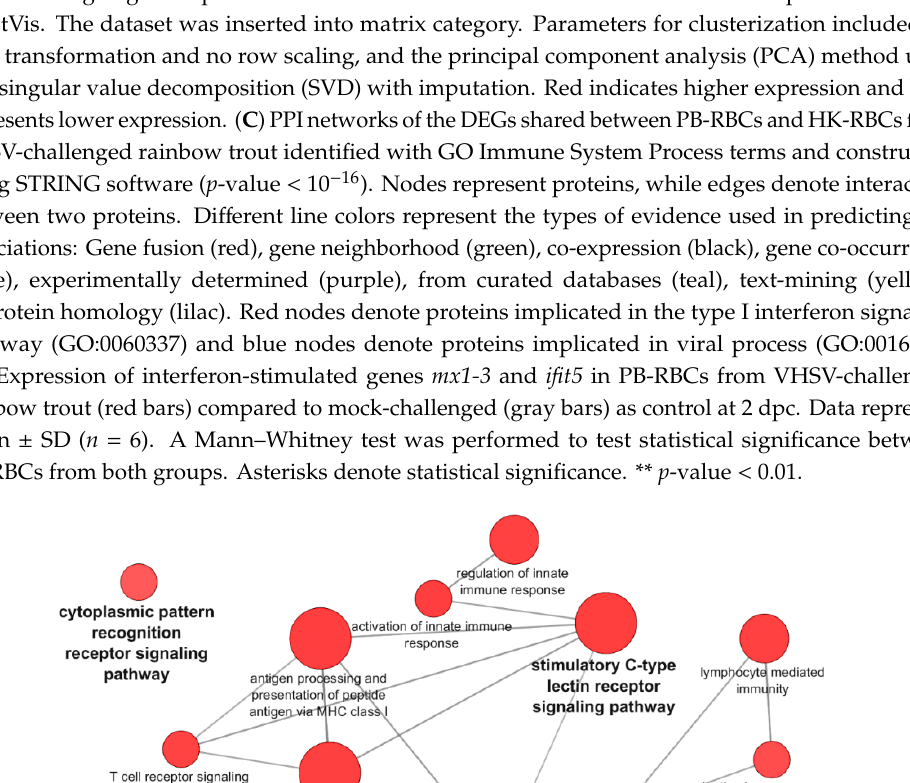
Figure 4. Pathways overrepresented in DEGs exclusive of PB-RBCs from VHSV-challenged rainbow trout. Pathway enrichment analysis was performed using GO Immune System Process terms with p -value < 0.05, GO Term fusion, and GO Tree interval of 3–8.